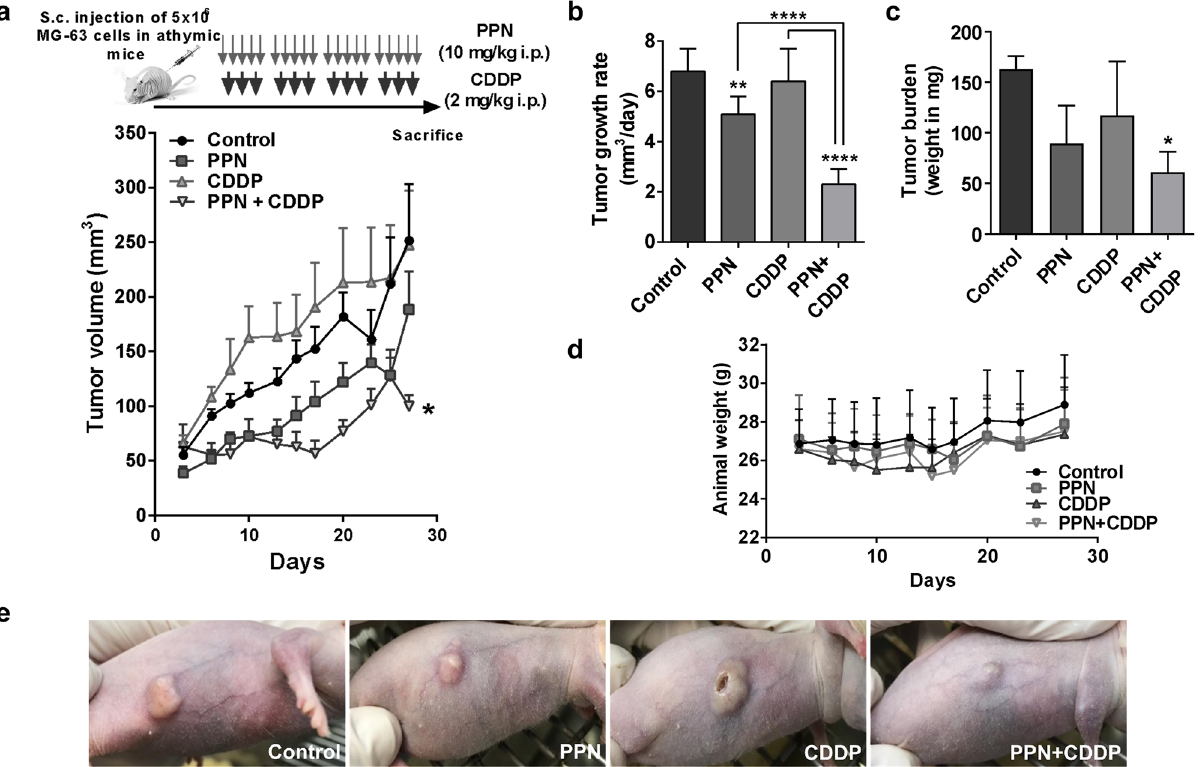
Figure 6. Propranolol in combination with low-dose metronomic cisplatin inhibits osteosarcoma tumor growth without overt signs of toxicity. ( a ) Experimental design used to evaluate in vivo effects of propranolol (PPN, 10 mg/kg i.p.) plus cisplatin (CDDP, 2 mg/kg i.p.) on tumor progression of MG-63 xenografts growing in athymic mice (Top). Curves represent mean tumor volumes of mice receiving saline vehicle (control), PPN, CDDP or PPN plus CDDP over time (bottom). 5 animals per experimental group. ( b ) Aggressiveness of osteosarcoma (OSA) xenografts was additionally assessed by calculating tumor growth rates between days 3 and 27 of protocol. ( c ) Final tumor burden was evaluated by weighing resected OSA primary lesions after necropsy. ( d ) Body weight of animals bearing MG-63 xenografts belonging to different experimental groups throughout the protocol. ( e ) Representative photographs of nude mice bearing OSA xenografts belonging to different experimental groups at day 30 are shown. Data are presented as mean ± SEM. * p < 0.05, ** p < 0.01, **** p < 0.0001. ANOVA followed by Tukey’s